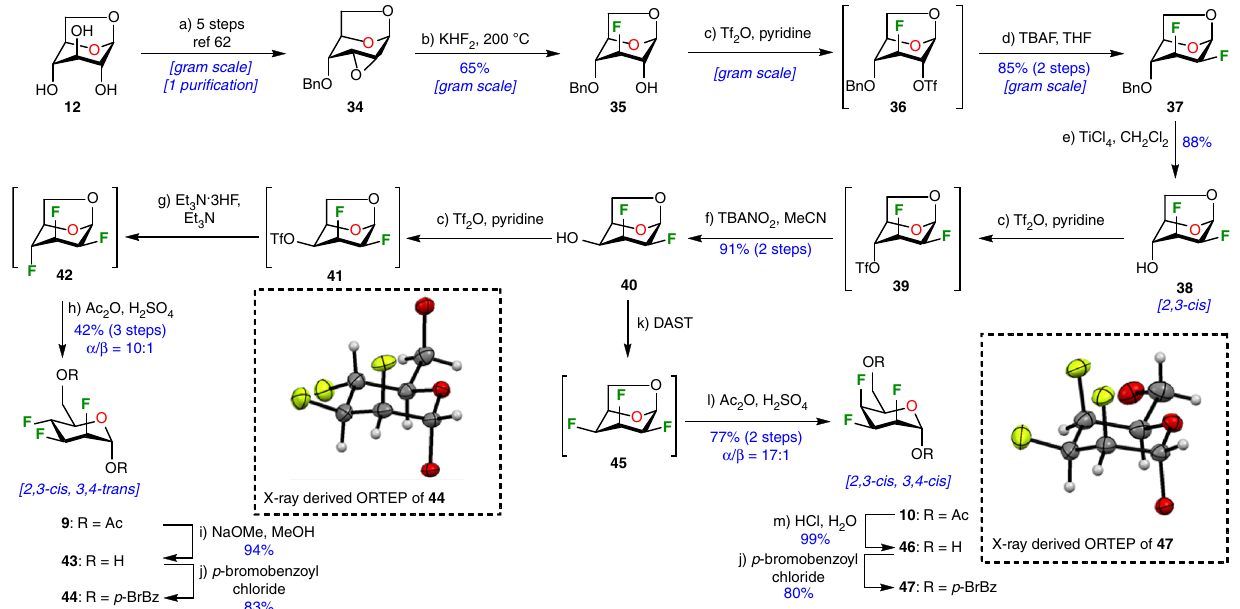
Fig. 6 Synthesis of 2,3,4-trideoxy-2,3,4-tri fl uoromannopyranose 44 and 2,3,4-trideoxy-2,3,4-tri fl uorotalopyranose 47 . Reagents and conditions: (a) ref 63 ; (b) KHF 2 (6.1 equiv), ethylene glycol, 200 °C, 5.0 h, 65%; (c) Tf 2 O (2.4 equiv), pyridine (9.6 equiv), CH 2 Cl 2 , 0 °C, 0.5 h; (d) 1 M TBAF in THF (10 equiv), THF, rt, 22 h, 85% over 2 steps; (e) TiCl 4 (2.0 equiv), CH 2 Cl 2 , 0 °C, 0.8 h, 88%; (f) TBANO 2 (3.0 equiv), CH 3 CN, microwave irradiation, 100 °C, 3 h, 91% over 2 steps; (g) Et 3 N·3HF (15 equiv), Et 3 N, 80 °C, 48 h; (h) Ac 2 O (200 equiv), H 2 SO 4 (80 equiv), 0 °C to rt, 16 h, then NaOAc (100 equiv), 0 °C to rt, 0.3 h, 71% over 3 steps, 9 / 10 = 1.5:1, α / β = 10:1; (i) 1 M NaOMe, MeOH, rt, 1 h, 94%; (j) p -bromobenzoylchloride (4.0 equiv), Et 3 N (8 equiv), DMAP (0.8 equiv), CH 2 Cl 2 , rt, 18 h, 83% for 44 , 80% for 47 ; (k) DAST (2.0 equiv), CH 2 Cl 2 , microwave irradiation, 100 °C, 1 h; (l) Ac 2 O (30 equiv), H 2 SO 4 (10 equiv), 0 °C to rt, 16 h, then NaOAc (20 equiv), 0 °C to rt, 0.3 h, 77% over 3 steps, α / β = 23:1; m) HCl (37% in water), water, rt, 1 h. Ac 2 O acetic anhydride, DAST diethylaminosulfur tri fl uoride, DMAP 4-(dimethylamino)pyridine, TBAF tetrabutylammonium fl uoride, TBANO 2 tetrabutylammonium nitrite, Tf 2 O tri fl uoromethanesulfonic anhydride. ORTEP diagram of the molecular structure of 44 and 47 showing 50% thermal ellipsoid probability, carbon (gray), oxygen (red), fl uorine (light green), hydrogen (white). The ORTEP plots do not show the complete molecule (benzoate moieties have been omitted for clarity)